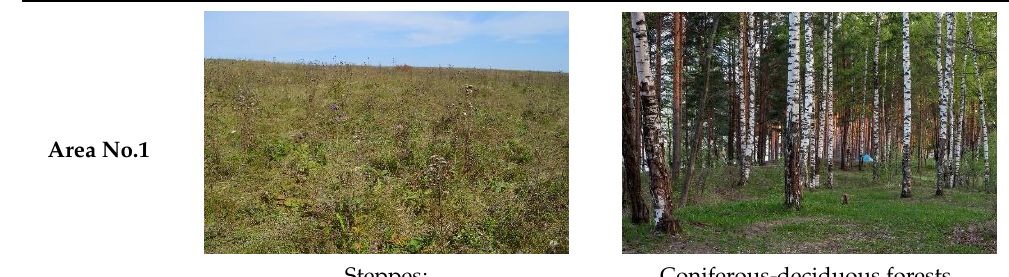
Table 2. Photos of plant communities growing in study areas.